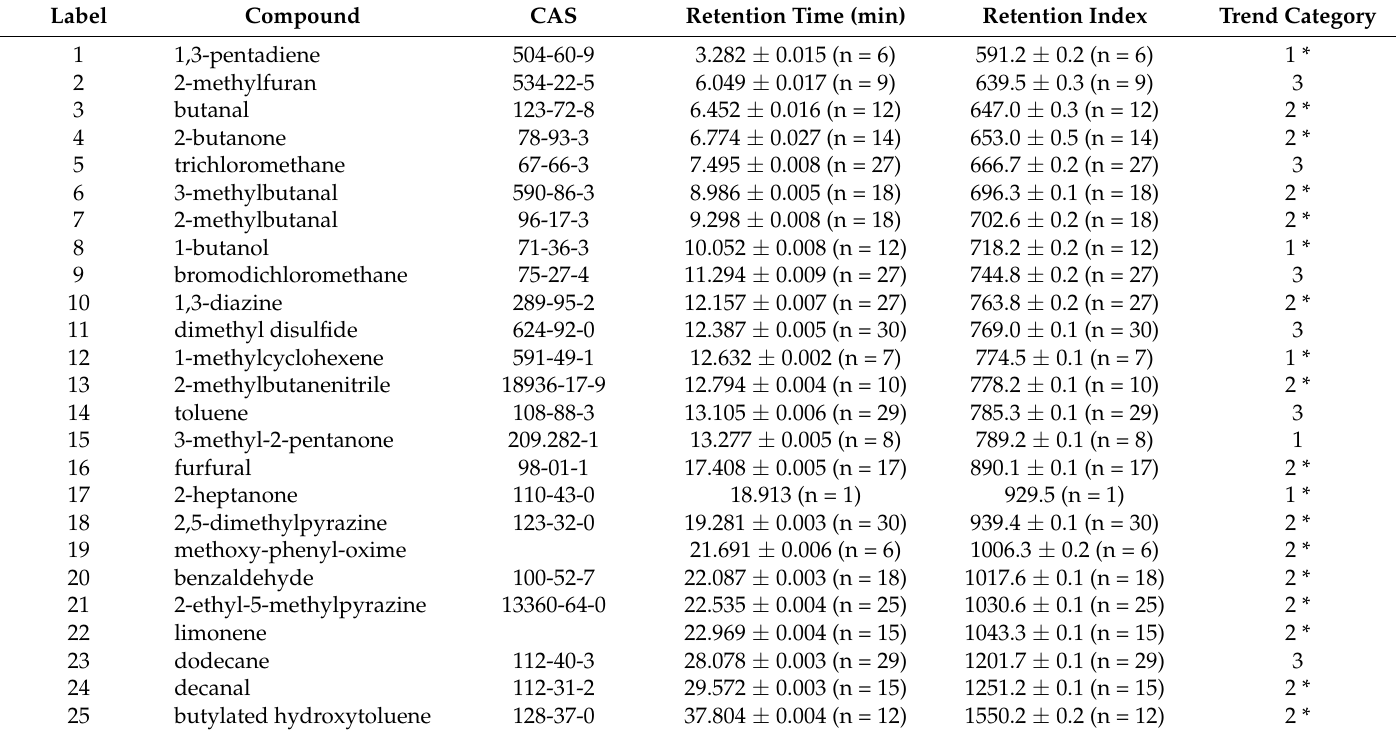
Table 1. Compounds of interest identified from solid-phase microextraction (SPME) Arrow sampling of Bacillus subtilis over a five-day period. Compound labels refer to labels in Figures 4 and 5. The number of samples used to calculate retention time and retention index for each compound is listed for each value. The longitudinal data for each compound of interest was tested for significance (*) when comparing the level of the compound in the uninoculated control to the bacterial sample over five days. Significance was tested using an unpaired two-tailed Student’s t -test with α =